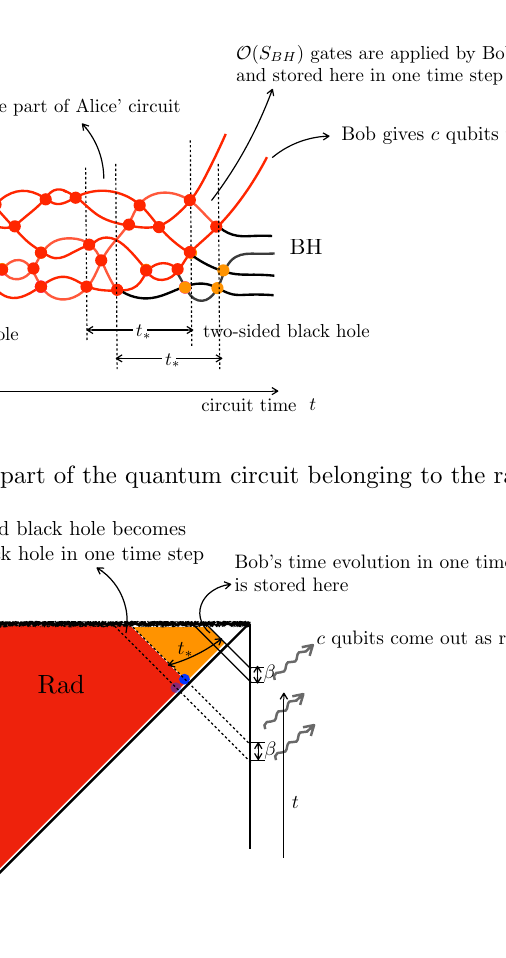
Figure 13 . The blue dot represents the RT surface. It moves along the horizon and always stays scrambling time